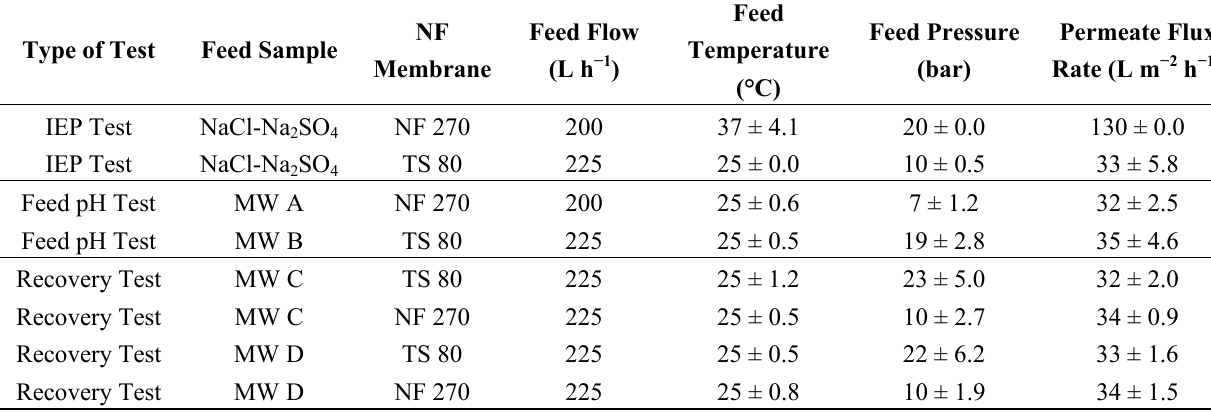
Table 3. Details of experimental tests conducted on four mine influenced water samples and two nanofiltration